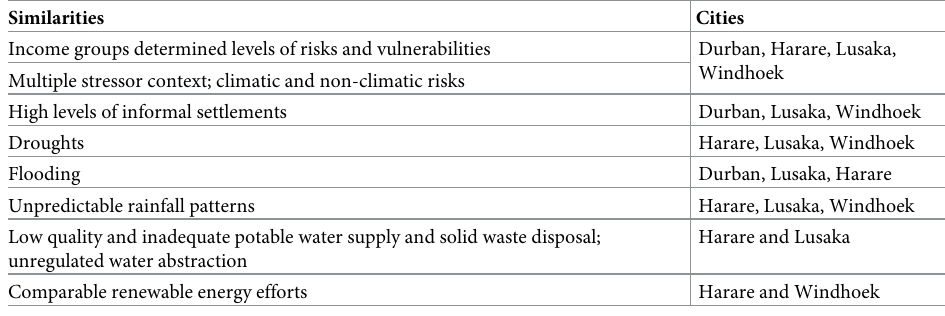
Table 3. Similarities across the study cities.